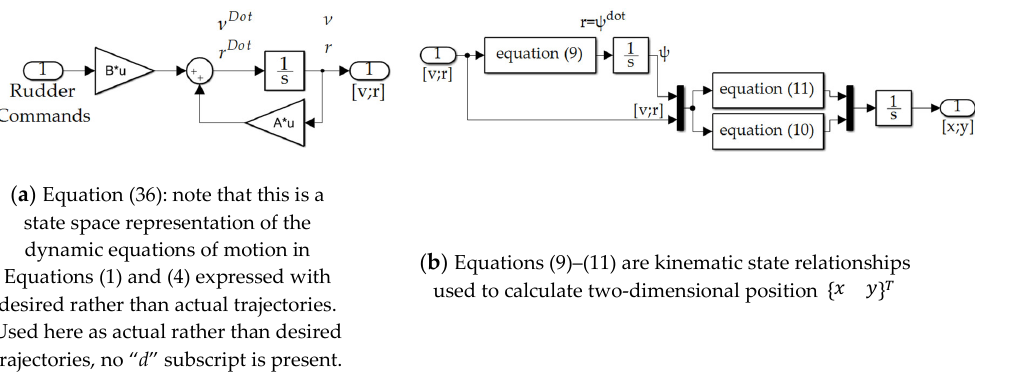
Figure 9. SIMULINK simulation program representing the right-most subsystem in Figure 6.